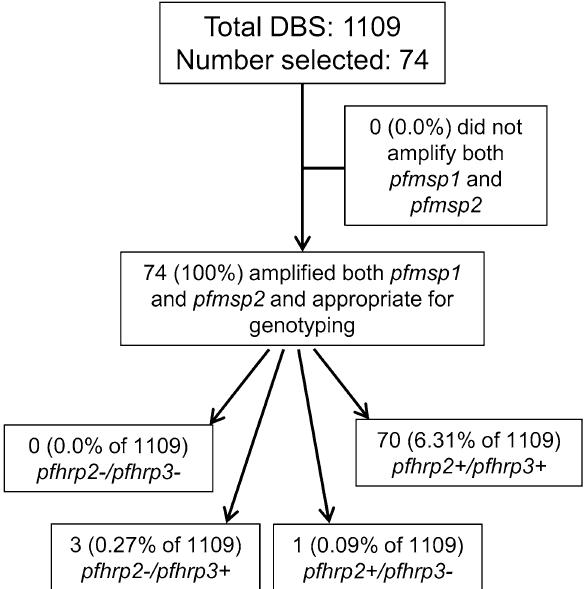
Figure 2. Sample processing and results for pfhrp2 and pfhrp3 genotyping in the Democratic Republic of the Congo. Results presented as a flowchart for the entire sample set available for antigen screening. Terminal boxes show the presence ( +) or absence ( −) of the pfhrp2 and pfhrp3 genes from samples appropriate for genotyping. All percentages shown are out of the total 1109 DBS samples analyzed.